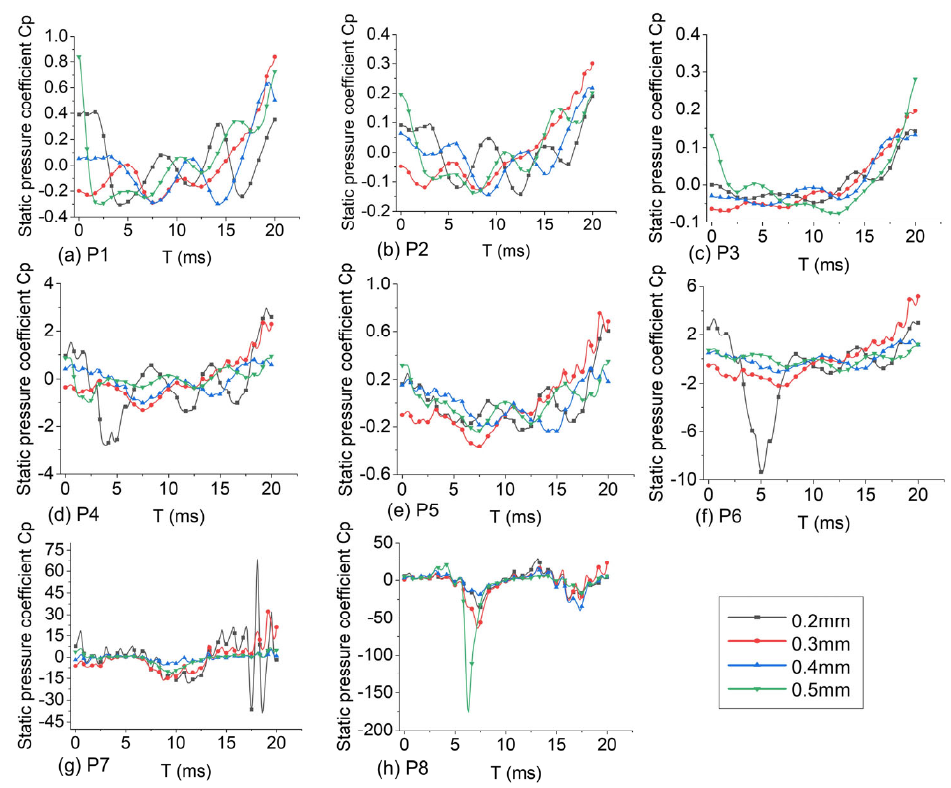
Figure 9. Time domain diagram of pressure fluctuations at monitoring points: ( a ) P1, ( b ) P2, ( c ) P3, ( d ) P4, ( e ) P5, ( f ) P6, ( g ) P7 and ( h ) P8.